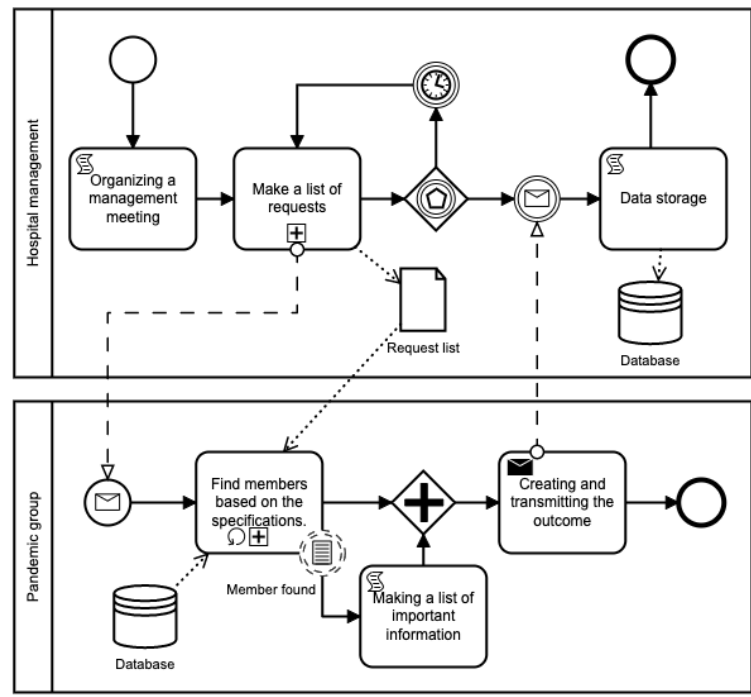
Figure 11. Creating a list of pandemic group